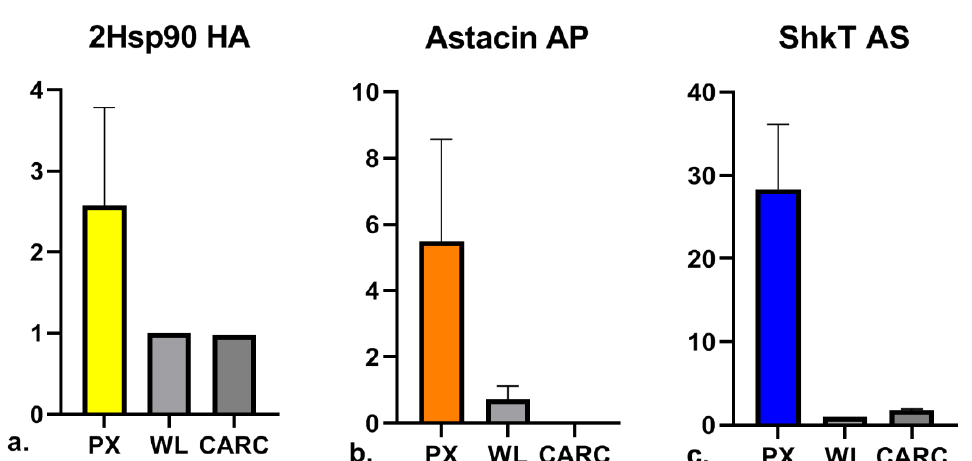
Figure 4. RTqPCR validation of transcript abundance. Graphs summarize the relative quantification